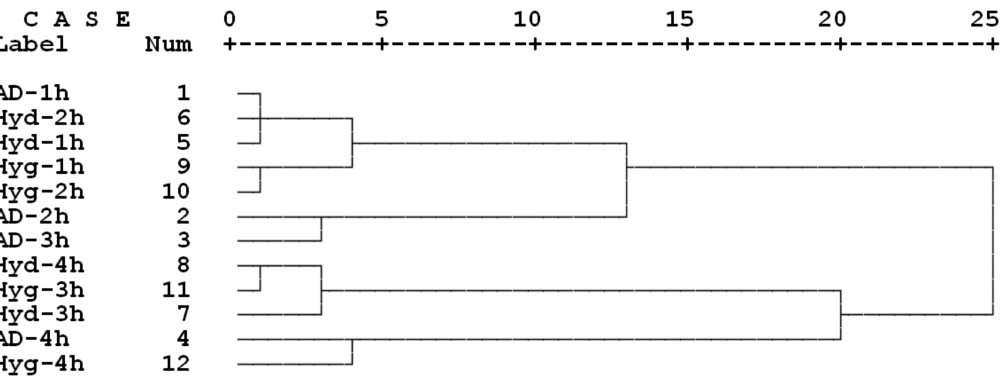
Figure4. Clusteranalysisofthethreetypesofheat-treatments(hot-air, hydrothermal, andhygrothermal) at four durations of 1, 2, 3, and 4 h each (AD = hot-air treatment; Hyd = hydrothermal; Hyg = hygrothermal